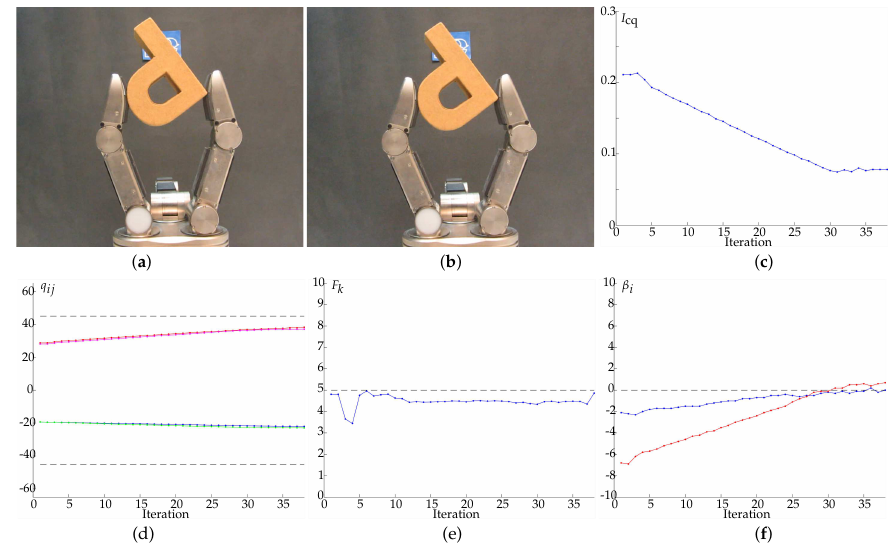
Figure 16. Example 6. ( a ) Initial grasp. ( b ) Final grasp. ( c ) Evolution of the index I cq = 0.5 I hc + 0.5 I gq . ( d ) Evolution of the joints values in degrees, q 11 in blue, q 12 in red, q 21 in green, q 22 in magenta. ( e ) Average force F k in Newtons, the dashed line indicates F d . ( f ) Angles β i in degrees, β 1 in blue and β 2 in red (the dashed line indicates the optimal value of β i